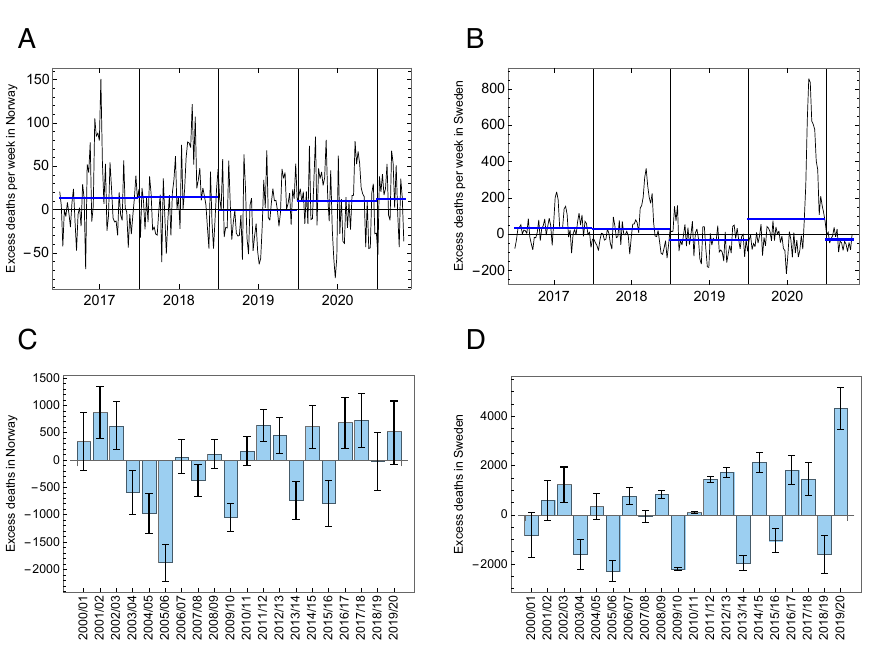
Figure 2. Excess mortality. ( A ) Weekly excess mortality for Norway from 2016/17 and through the first months of the epidemic year 2020/21. The blue lines are the average values for each of the five epidemic years. ( B ) As ( A ), but for Sweden. ( C ) The annual excess mortality for Norway from 2000/01 to 2019/20. The error bars are the 95% confidence intervals. ( D ) As ( C ), but for Sweden. Table 2. Excess mortality per (epidemic) year. The excess mortality is defined as the registered deaths per year minus the expected number of deaths. The expected number of deaths are obtained from a model with a linear trend superposed on a seasonal signal. The confidence intervals are obtained by repeated re-estimates of the linear trend and seasonal signal in a Monte–Carlo simulation. The asterisk in the last row indicates that epidemic year is not completed